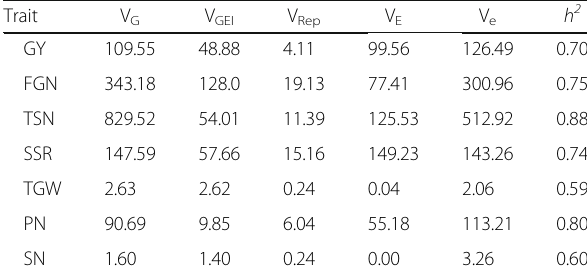
Table 1 Variance components and heritability estimates for agronomic traits investigated under salt stress conditions in 2016 and 2017